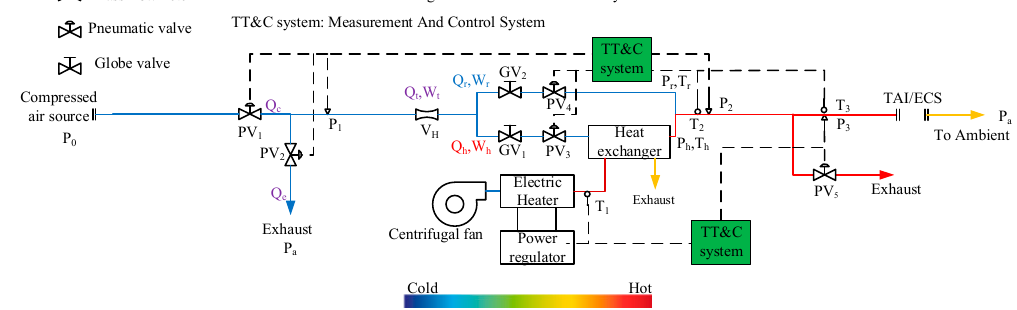
Figure 1. System flow chart of the laboratory equipment.